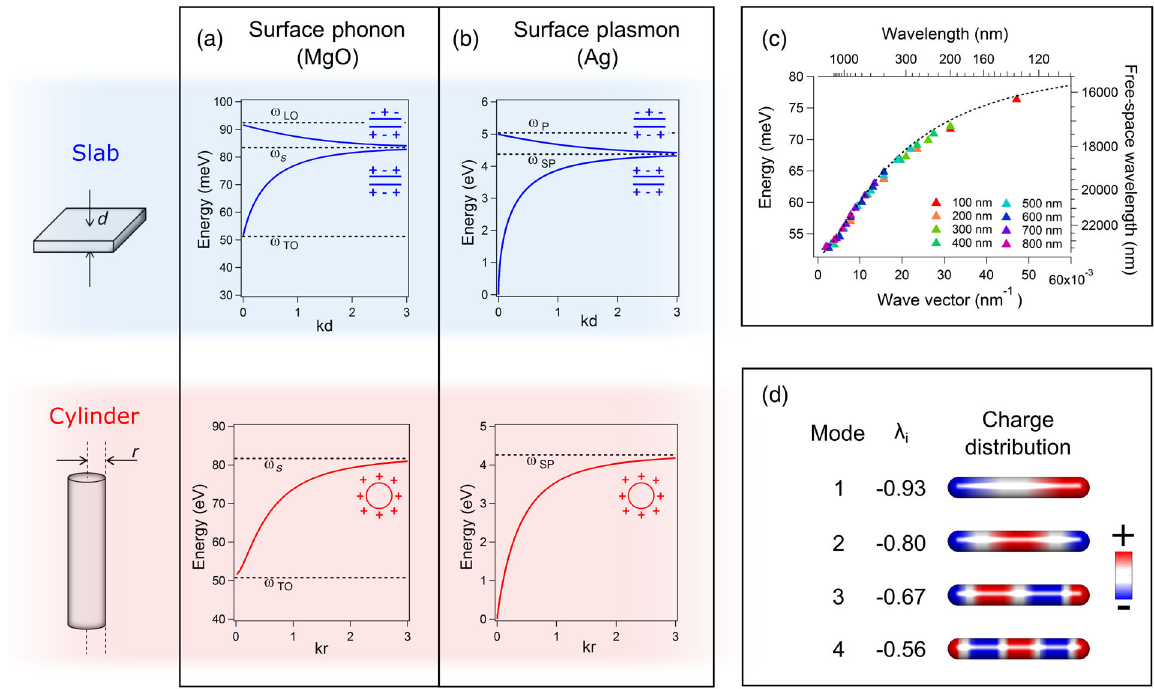
FIG. 1. Analogy between surface phonons modes and surface plasmons modes. (a) Dispersion relation of the Fuchs-Kliewer modes for a slab of thickness d (top) and a cylinder (bottom) of radius r made up of MgO. The charge symmetry of the modes is sketched in the inset. For the cylinder, only the rotationally invariant mode branch is shown, as the other modes are essentially not dispersing [5]. Calculations have been performed in the quasistatic approximation (b) Same for SP modes in silver. (c) Dispersion relation for the cSPh of nanorods, reconstructed from a series of retarded simulation of nanorods of different lengths (diameter is 30 nm). The dotted line is the quasistatic dispersion relation for an infinite cylinder of the same diameter, showing the remarkable agreement between both approximations even for long lengths of rods. (d) Surface eigencharge distribution for cSPh of a nanorod, with the given mode orders and eigenvalues λ